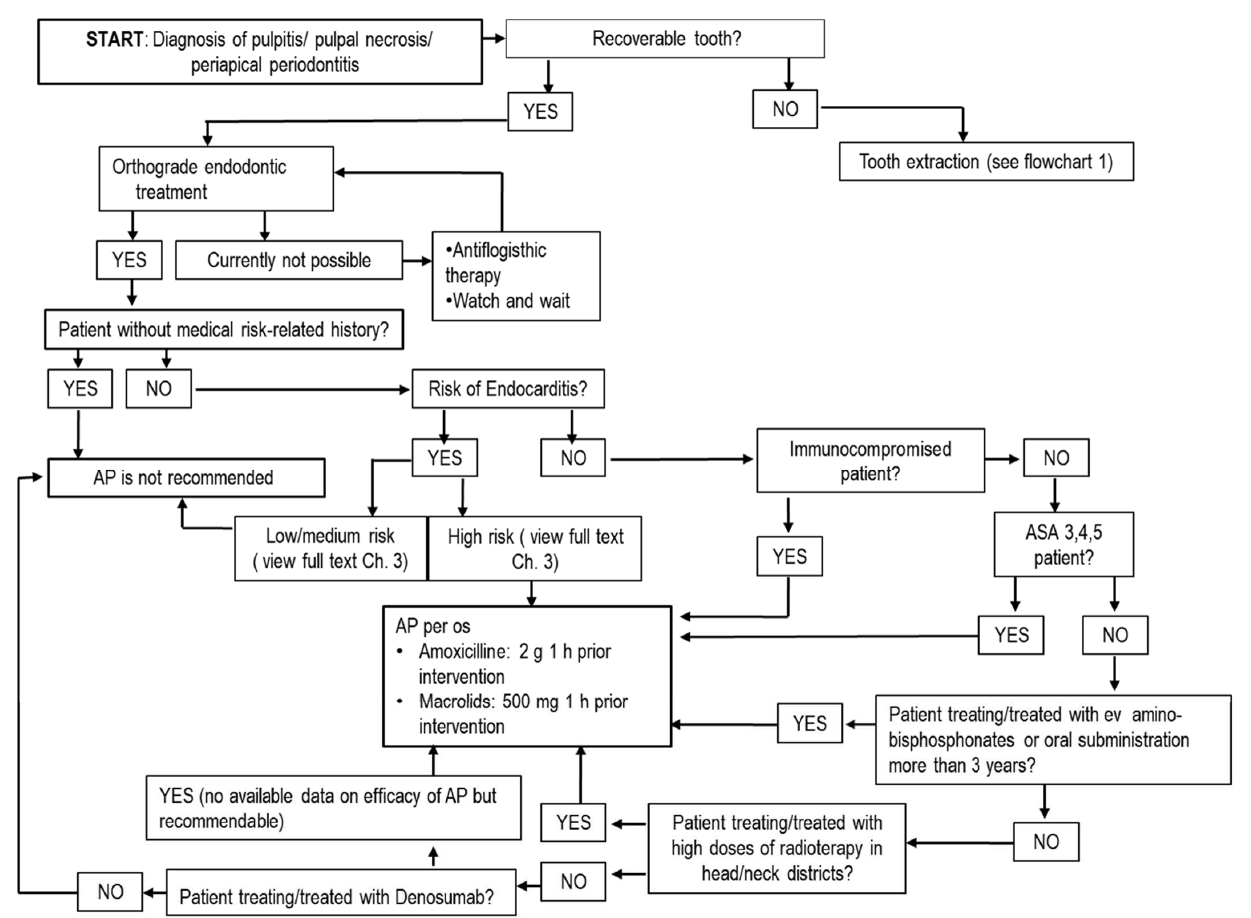
Figure 2. Flowchart for treatment of endodontic diseases in adult patients. In children, posology adjustments must be used, as described in Tables 1 and 2. Abbreviations: g = grams; mg = milligrams; h = hours; per os = oral administration; ev = endovenous administration; ASA = American Society of Anesthesiology; AP = Antibiotic prophylaxis.